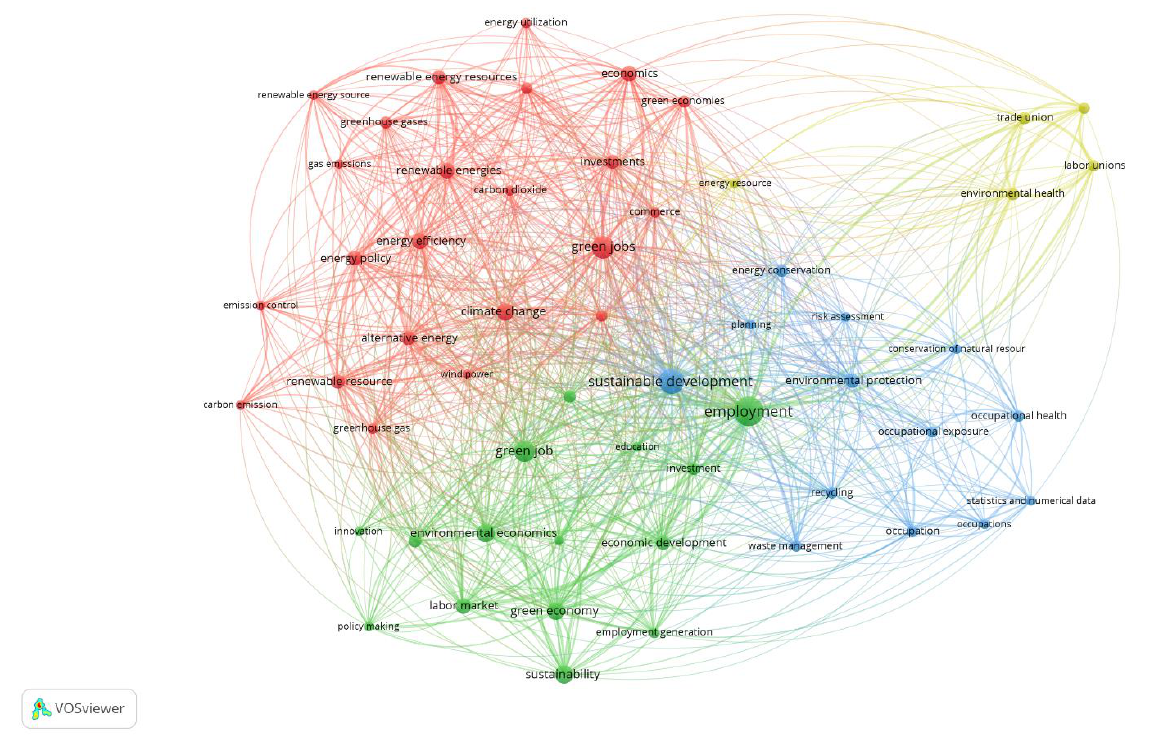
Figure 2. Bibliometric map of keywords co-occurrences Q4 results analysis in Scopus. Source: Authors’ elaboration. Table 3. Clusters of keyword co-occurrences presented in Figure 2 for Scopus Q4.